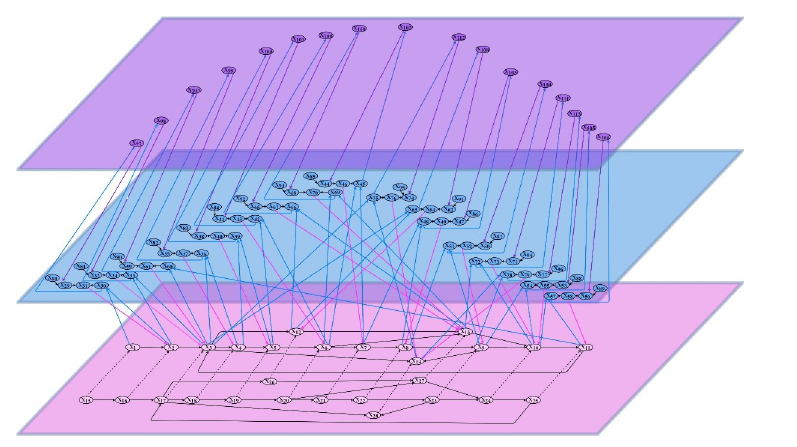
Fig 3. Connectivity for the complete adaptive network